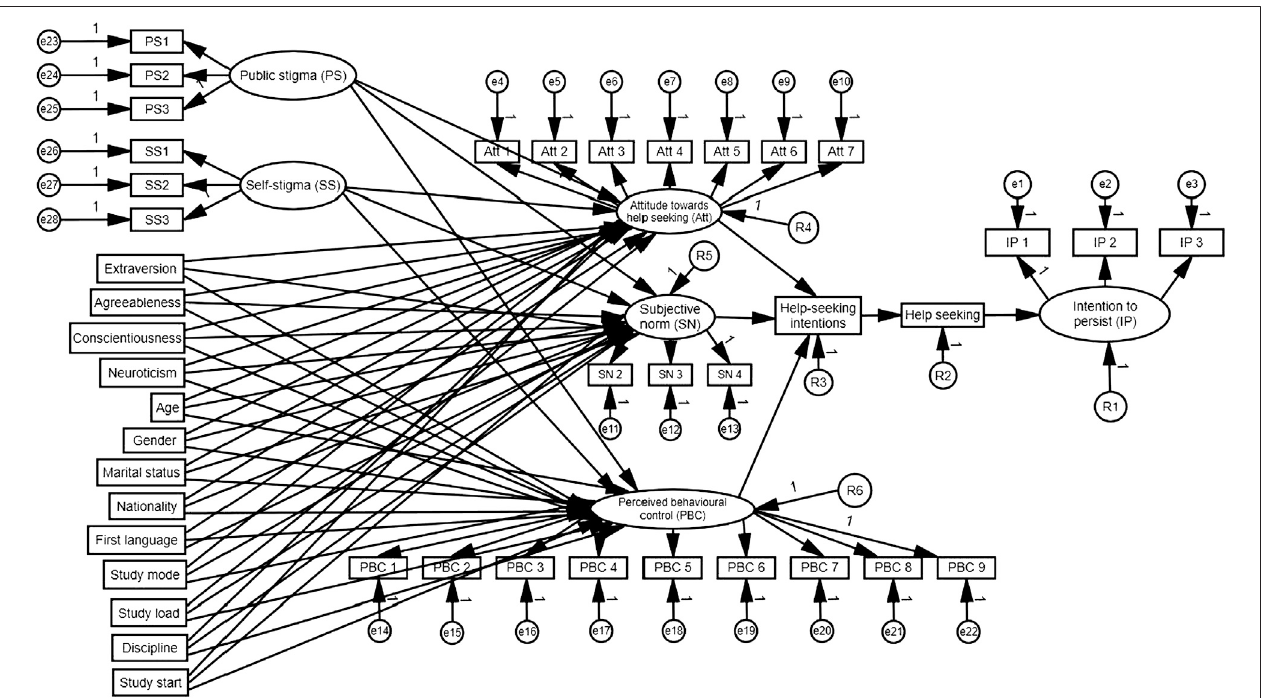
FIGURE 2 | Original academic help seeking